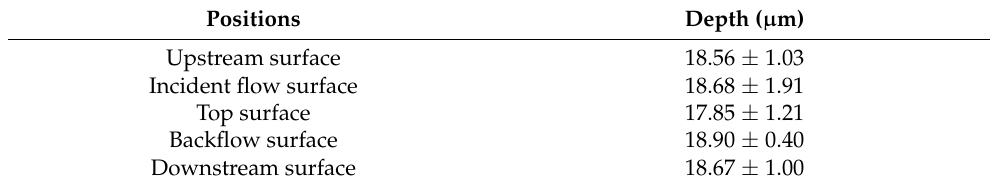
Table 3. Depth of the maximum pits on each surface of the WRH after removing the corrosion product.